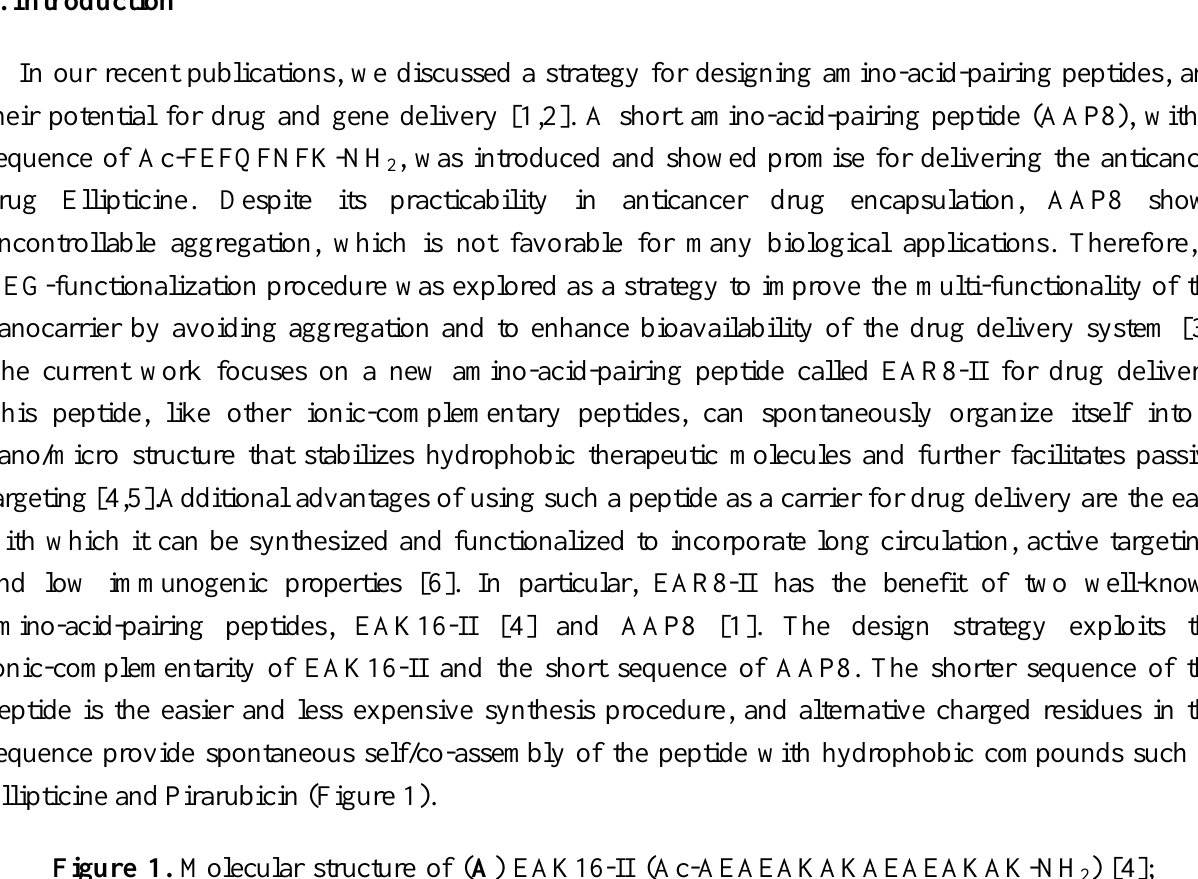
) [1]; ( C ) EAR8-II (Ac-AEAEARAR-NH 2